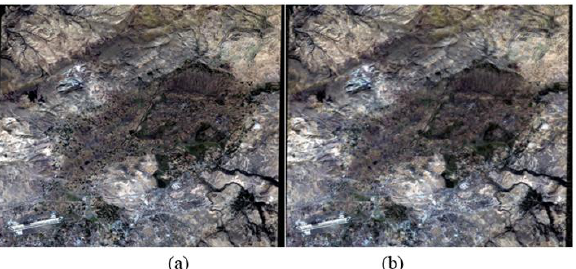
Figure 8: Daubechies Wavelets based fusion images; (a) 2- layered wavelets, (b) 4-layered